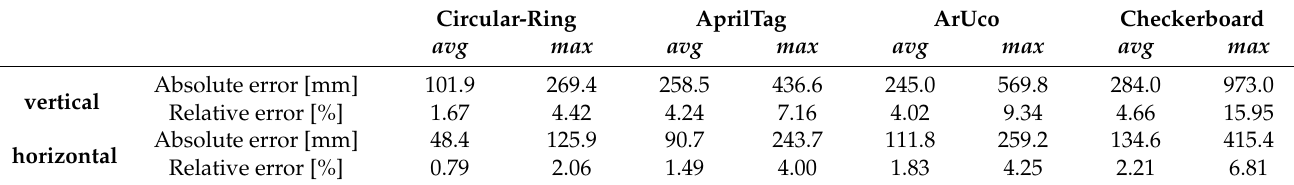
Table 9. Comparison of positioning accuracy at greater distances.